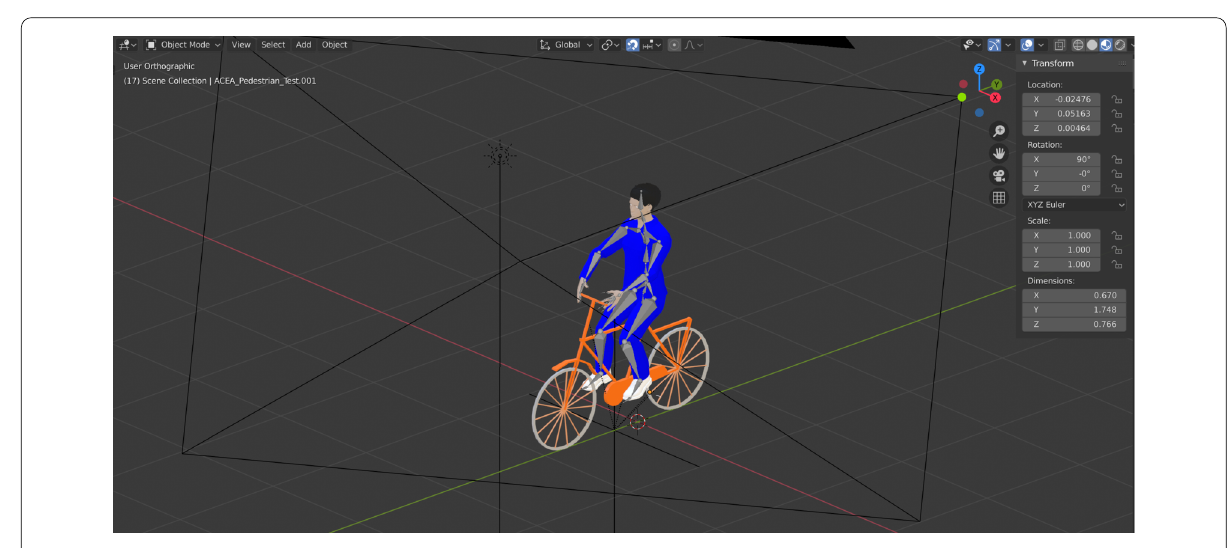
Figure 7 NCAP-testobject cyclist using software Blender